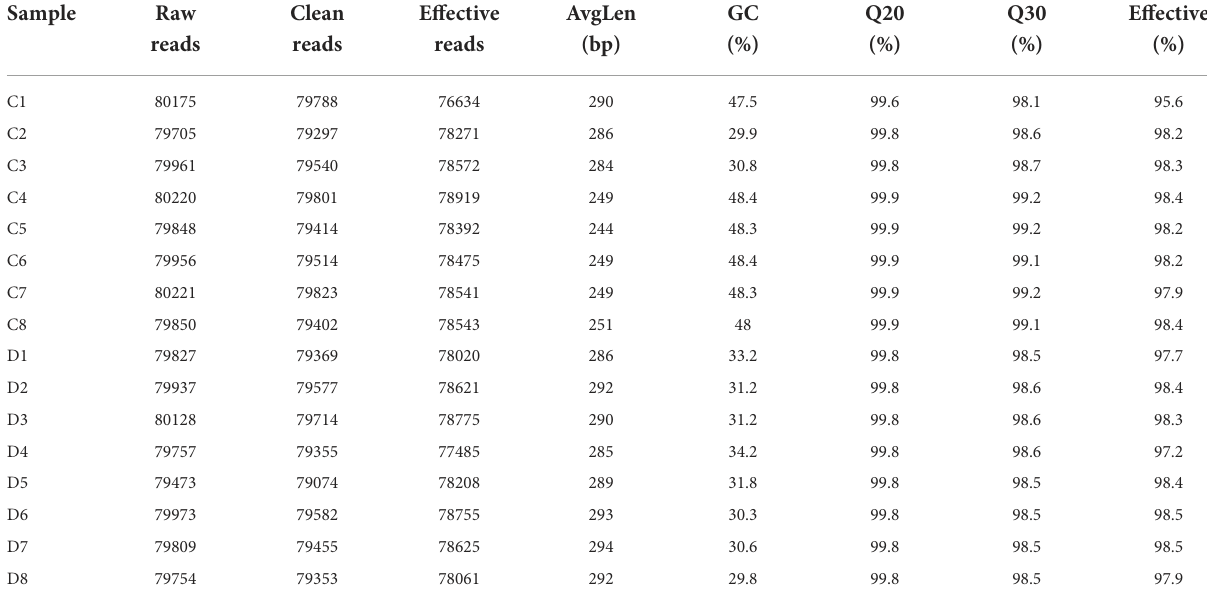
TABLE 1 Gut fungal sequence data of the